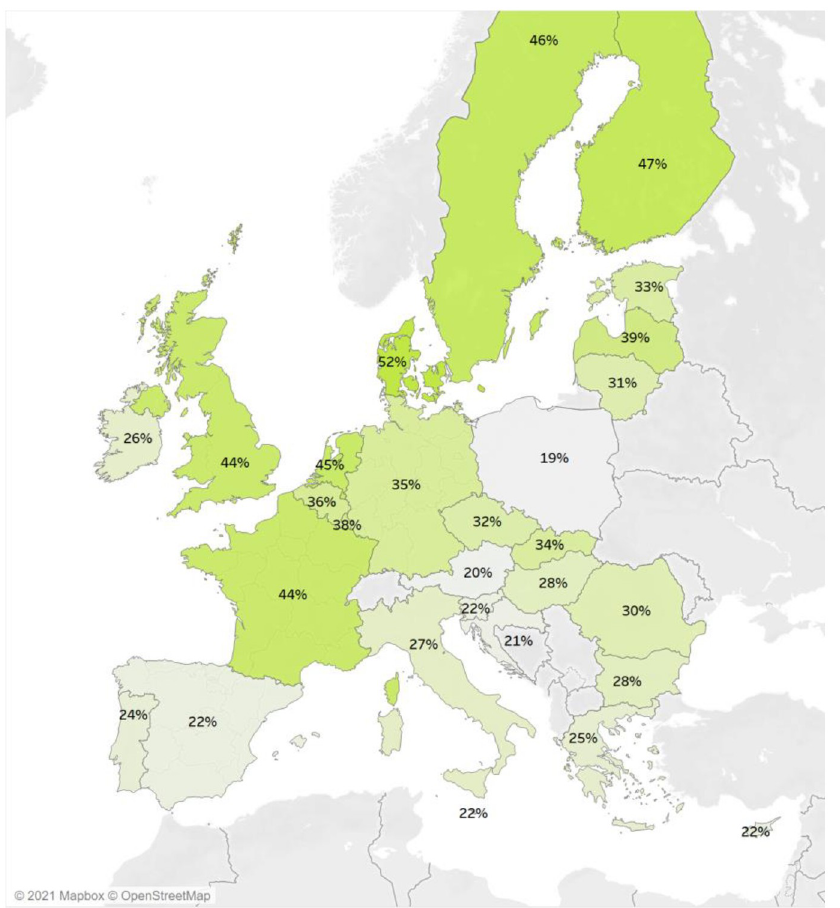
Fig 1. Disclosed prevalence of violence by Member State in 2012 (n = 41,954). Source: based on data from EU-wide Survey on Violence Against Women Note: EU average 32%.